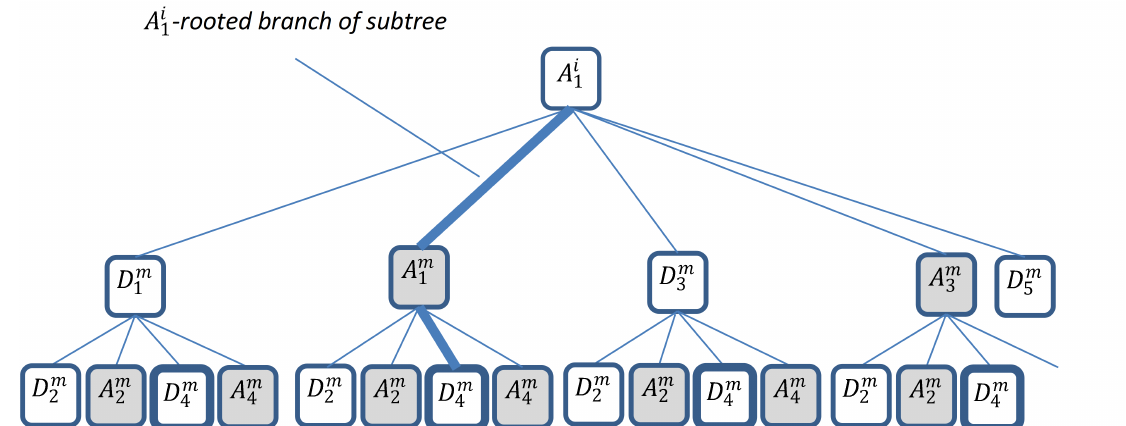
Figure 5. A fragment of a tree of initial technological operation network cuts.